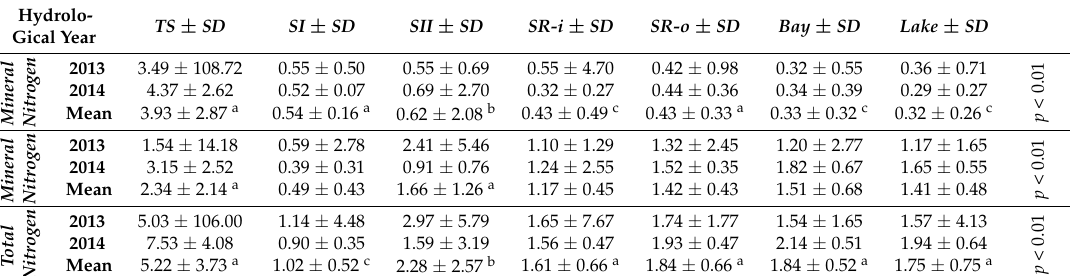
Table 1. Concentrations of mineral, organic, and total nitrogen in the surface waters of the Lake Symsar drainage area (results of the Kruskal–Wallis test and the post-hoc test. a , b and c represent differences in groups at the following levels of significance: a : p < 0.001, b : p < 0.01, c : p < 0.001 and p <